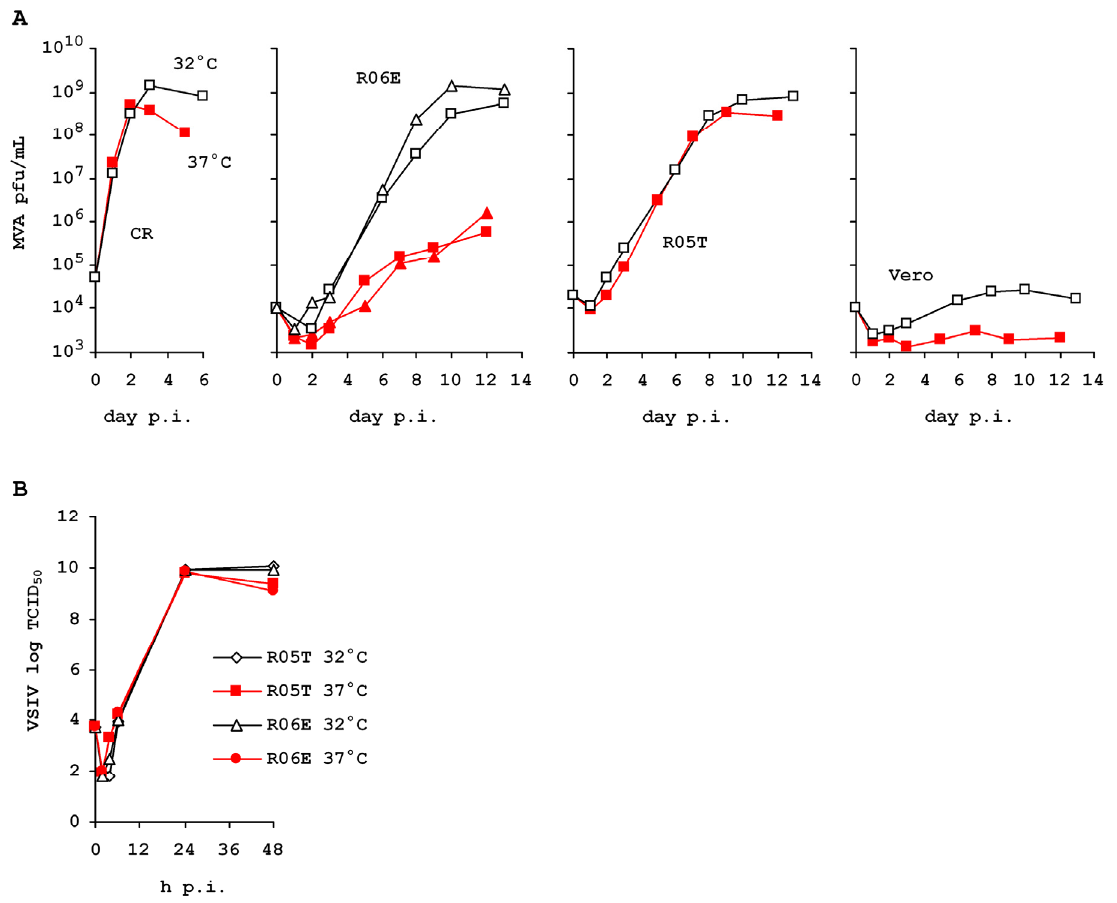
Figure 4. R06E at passages 50 and 90 has reduced permissivity for MVA ( A ) but not for VSIV ( B ) at 37 °C. R06E examined for VSIV was at passage 60. Cultivation and infection at 37 °C is highlighted in red with bold symbols, at 32 °C in black with open symbols. Lower passage R06E in the second panel of ( A ) is shown with squares and higher passage R06E is shown with